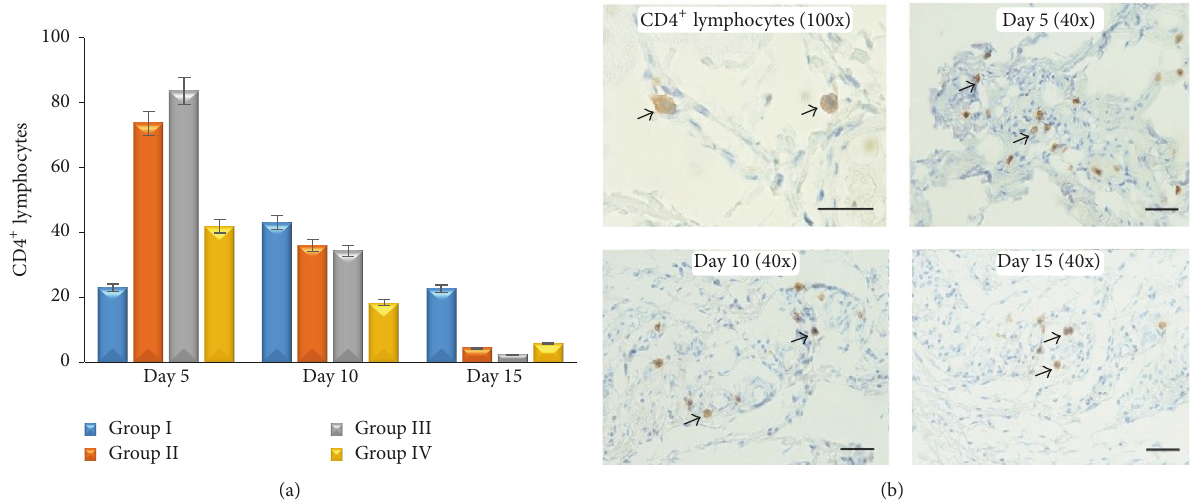
Figure 4: The average number of CD4 + lymphocytes (a); microscopical examination of CD4 + lymphocytes on skin wound (IHC antibody anti CD4 + , DAB, scale bar 50 𝜇 m).